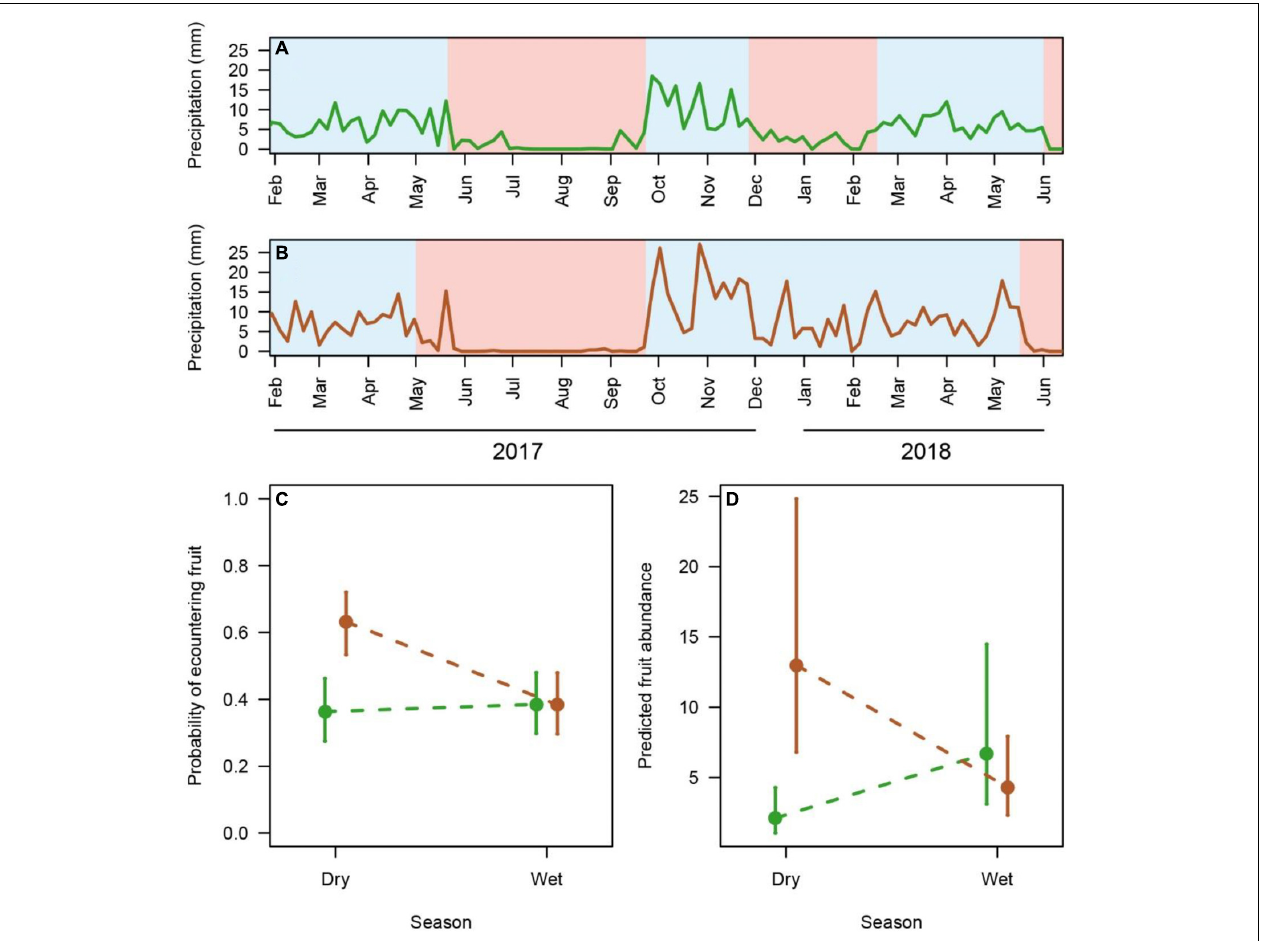
FIGURE 2 | Pentad mean daily rainfall trends for Ivindo (A) and Wonga Wongué (B) and predicted fruit encounter probability (C) , and fruit abundance (D) from the best supported models across sites and seasons. Where: green = Ivindo; brown = Wonga Wongué; blue sections (A,B) = dates assigned as wet seasons; pink sections (A,B) = dates assigned as dry season; points (C,D) = estimated fruit presence or abundance from the best supported model; bars = 95% confidence intervals around the fixed effects.